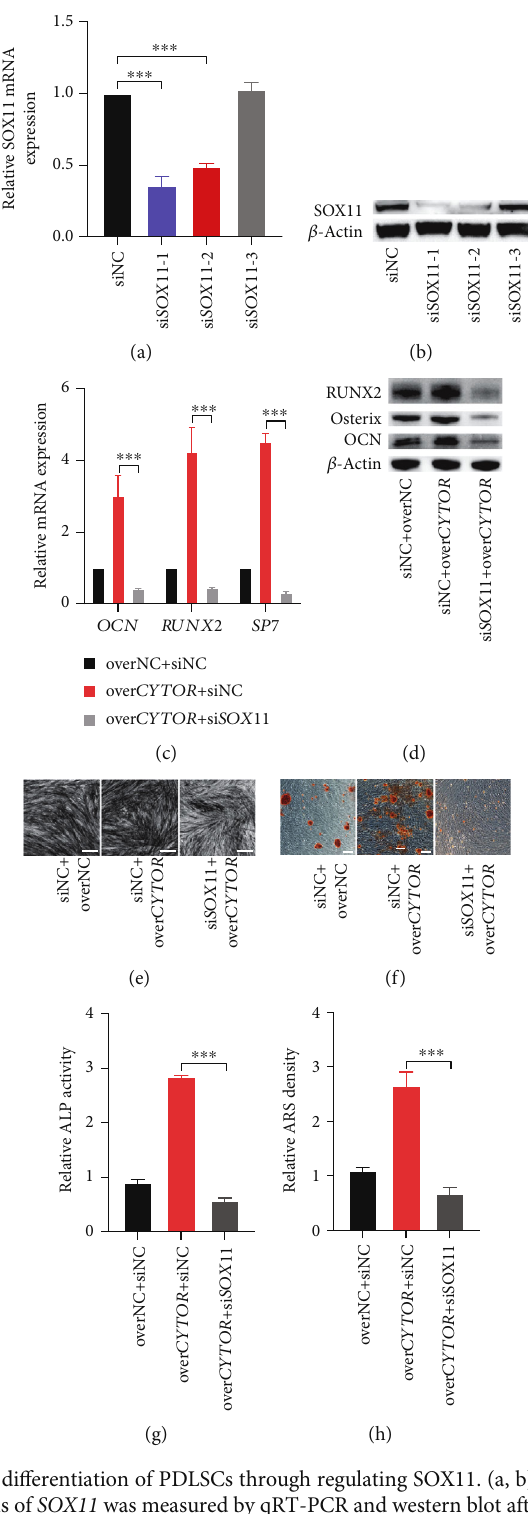
Figure 5: CYTOR promotes osteogenic di ff erentiation of PDLSCs through regulating SOX11. (a, b) Veri fi cation of the e ff ect of knockdown on SOX11 . The mRNA and protein levels of SOX11 was measured by qRT-PCR and western blot after silencing SOX11 by si SOX11 . We used si SOX11 -1 to silence SOX11 in the subsequent experiments. (c, d) qRT-PCR and western blot were conducted to detected the mRNA (c) and protein (d) levels of osteogenic related markers in PDLSCs after cotransfected with si SOX11 and over CYTOR or their negative controls followed by 14 days ’ osteogenic di ff erentiation. (e) ALP staining was performed. (g) ALP activity of indicated groups were detected after 7 days ’ osteogenic induction. (f) Alizarin Red staining was performed to detect mineralized nodules formation of indicated groups. (h) Semiquanti fi cation of (f). ∗∗∗ p < 0 : 001 , compared with the group as